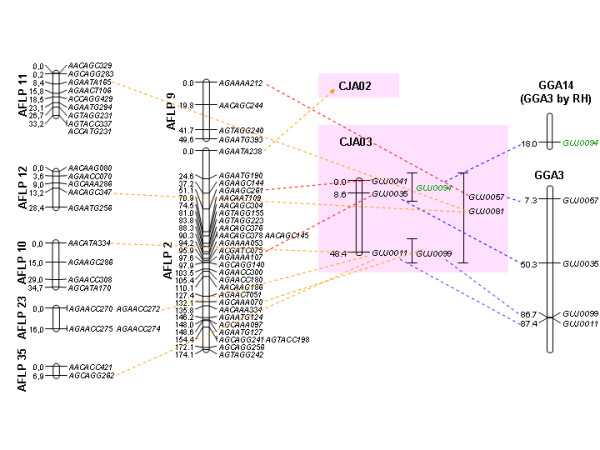
Alignments of Japanese quail microsatellite and AFLP maps and links to the assembled chicken sequence. Left: AFLP linkage groups from [14]; center: integrated microsatellite and gene map (this study); right: chicken February 2004 sequence assembly [22]. AFLP and microsatellite genetic maps are in cM and the sequence assembly is in Mb. New quail linkage groups have blue titles and new microsatellite and gene markers are in green. Genes are in boldface italic. Microsatellite markers informative in both species are in red boxes. Chicken markers have a yellow background. Quail microsatellites or genes with similarity to chicken sequence of unknown location (chrun) have a blue background. Dotted lines linking the microsatellite and the AFLP maps indicate positive results of two-point linkage between the markers, with supporting LOD scores of 3 to 6 (green), 6 to 10 (orange) or more than 10 (red).